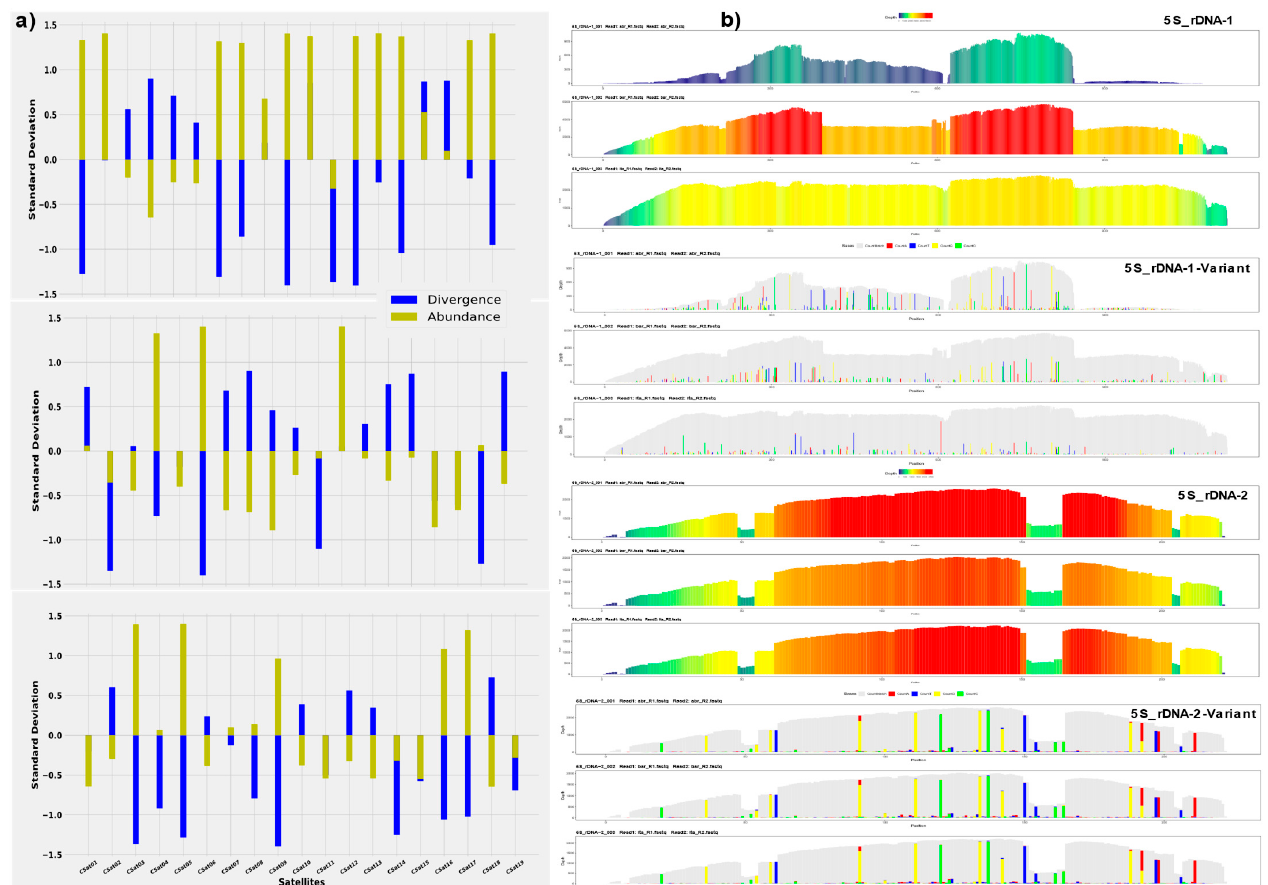
Figure 5. The standardized Z-score divergence and abundance values of each satDNA show the overall gain and loss ( a ) and the color-enhanced profiles of the 5S-rDNA across the three genomes. A 12 bp valley in the middle of the monomer site of (153–164) in the 5S-rDNA-2 profiles. Species profiles are arranged in a sequence of Calliptamus abbreviatus => Calliptamus barbarus => Calliptamus italicus ( b ).